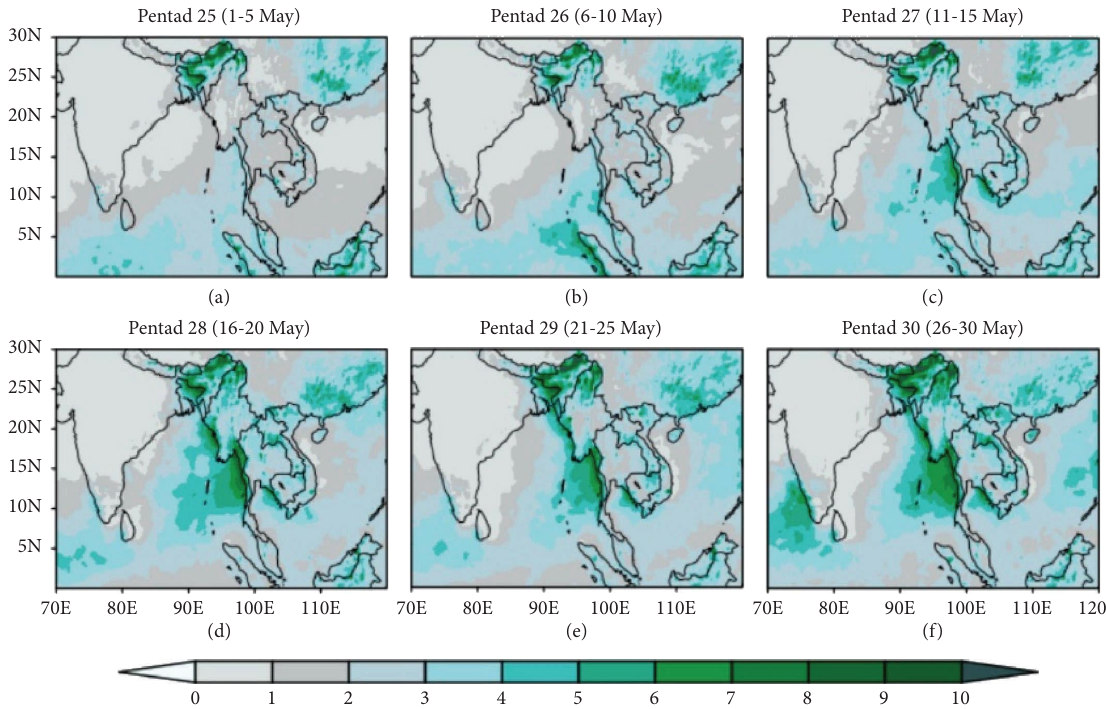
Figure 11: Composite of climatology (1991–2020) net precipitation (mm · day − 1 , colour) during the pentads: (a) P -25 (May 1–5), (b) P -26 (May 6–10), (c) P -27 (May 11–15), (d) P -28 (May 16–20), (e) P -29 (May 21–25), and (f) P -30 (May 26–30) during monsoon onset